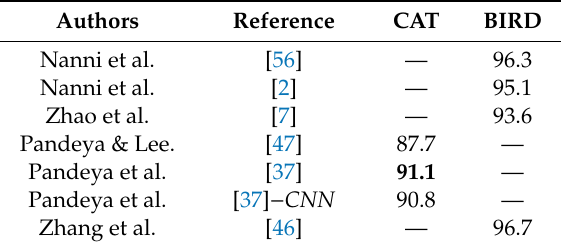
Table 7. Literature